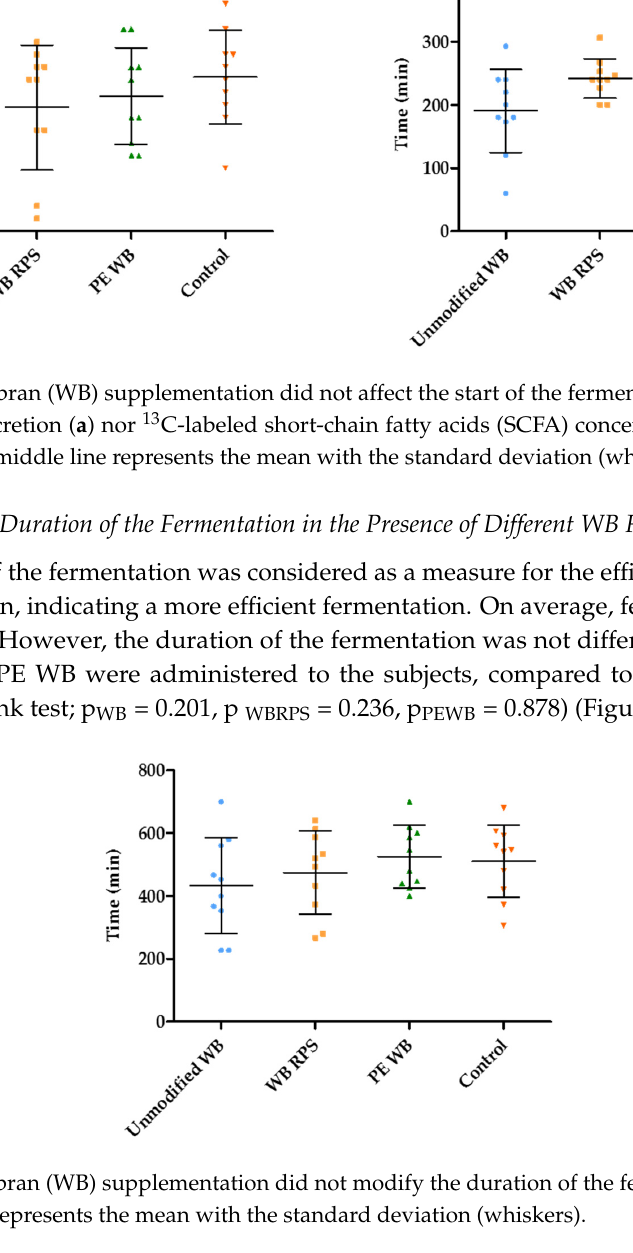
Figure 4. Both 13 C ‐ excretion in breath ( a ) and plasma 13 C ‐ SCFA concentrations ( b ) start to increase before the increase in breath 14 CO 2 ( n = 40).